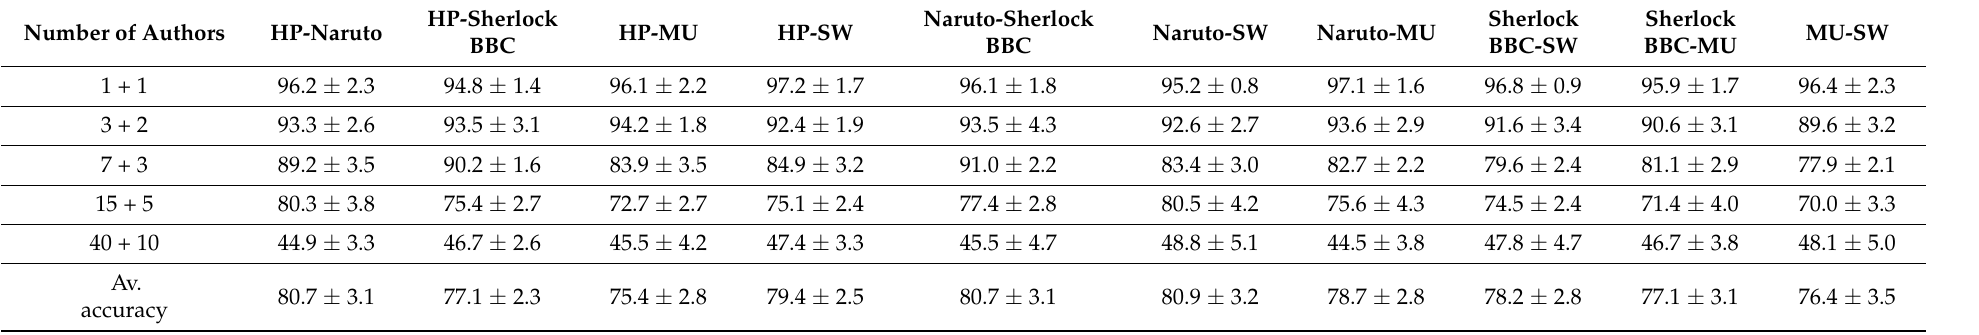
Table 13. Method based on cosine similarity thresholding for cross-topic